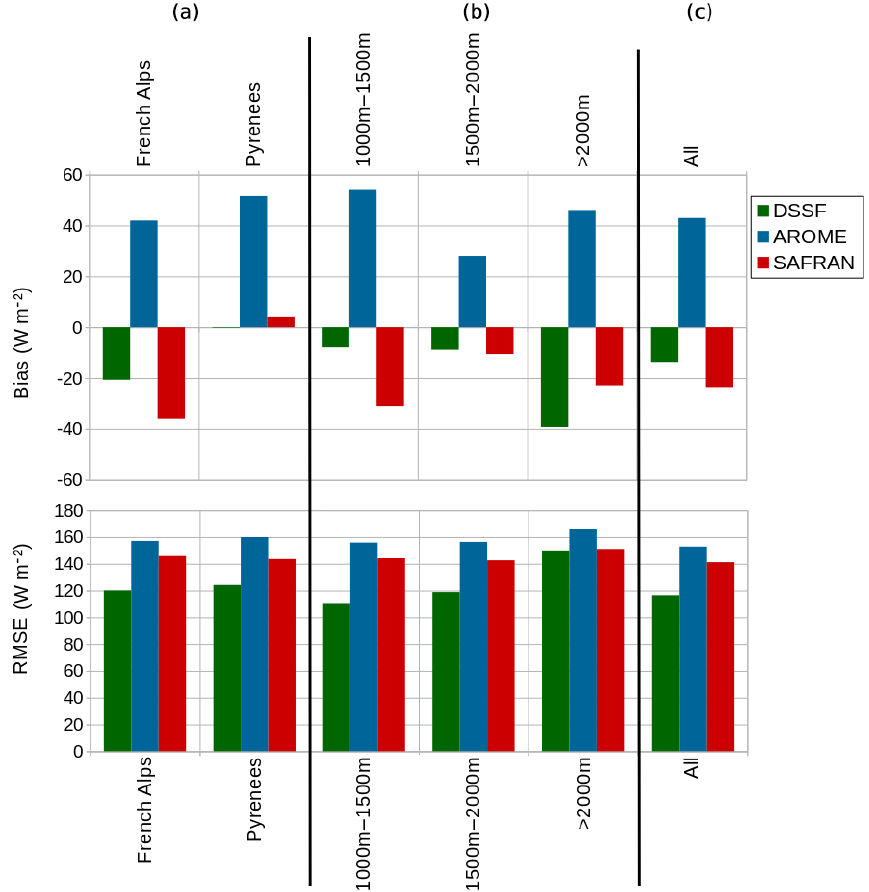
Figure 2. Bias and RMSE of SW ↓ irradiance products (DSSF in green, AROME in blue, SAFRAN in red) compared to stations organized by domain (a) , range of altitude (b) and all stations (c)